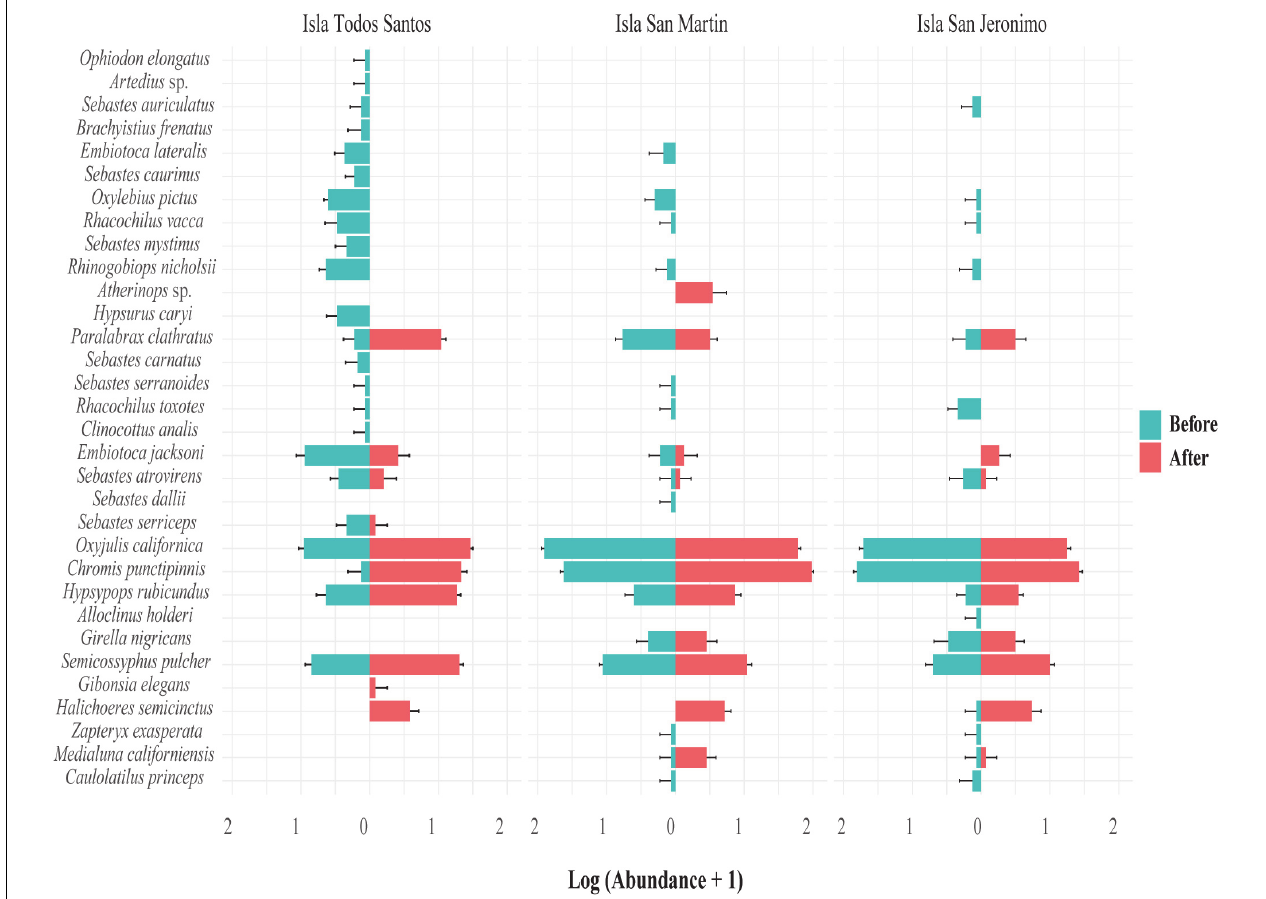
FIGURE 6 | Abundance (mean number of individuals, n = two sites with three census transects, ± 95% confidence intervals) of fish from before to after the 2014–2016 MHWs at Isla Todos Santos, Isla San Martin, and Isla San Jeronimo, in Baja California, Mexico. Fish species are organized based on their latitudinal distribution centroid, from north to